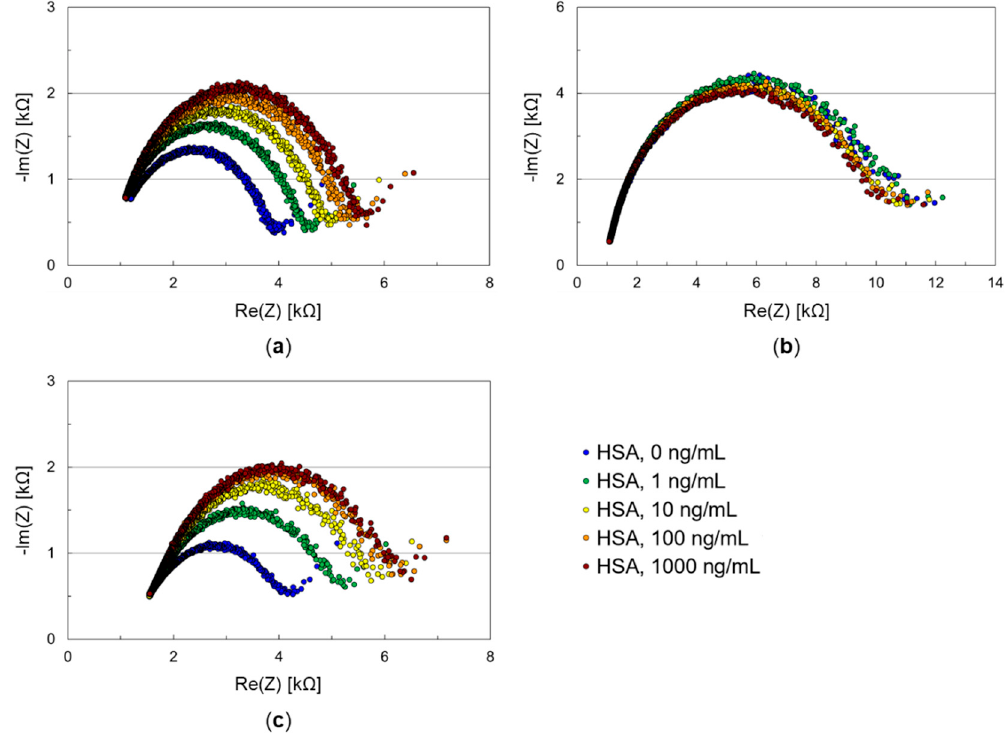
Figure 4. Nyquist plots of impedance biosensor chips for testing SAMs with HSA samples. Both working and counter electrode of such a chip were coated with ( a ) 4-mercaptobenzoic acid, ( b ) 1,4-benzenedithiol, or ( c ) 6-mercapto-1-hexanol. Samples containing HSA in increasing concentrations were applied subsequently to the biosensor chips.